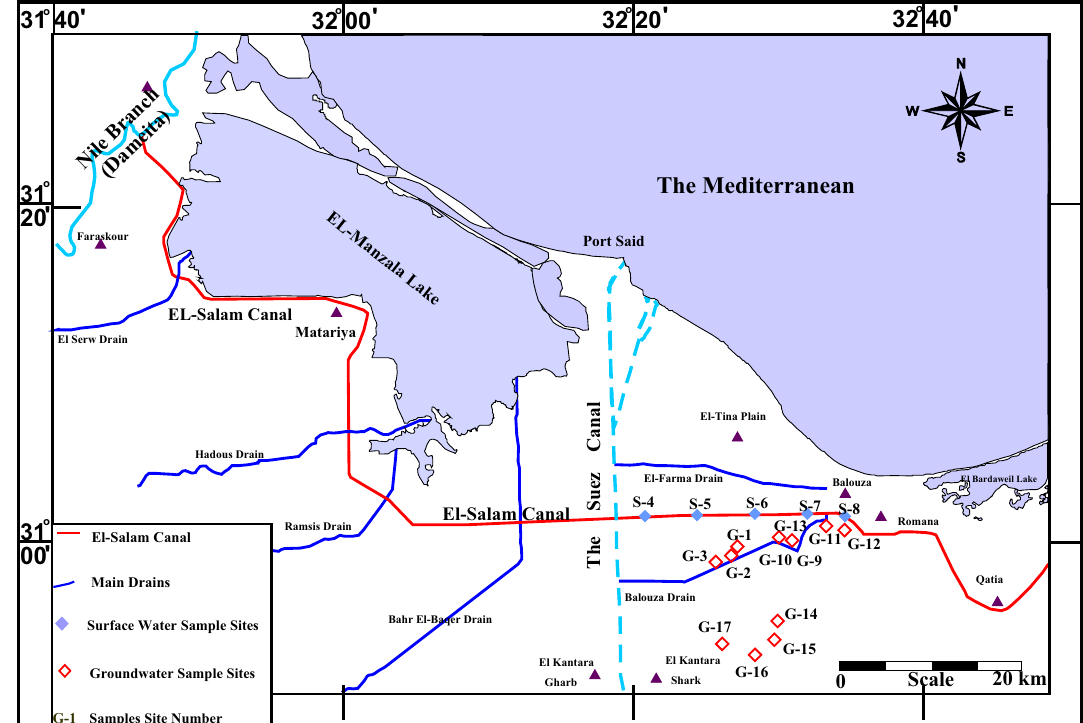
Fig. 1 Location sites of surface and groundwater samples along El-Salam